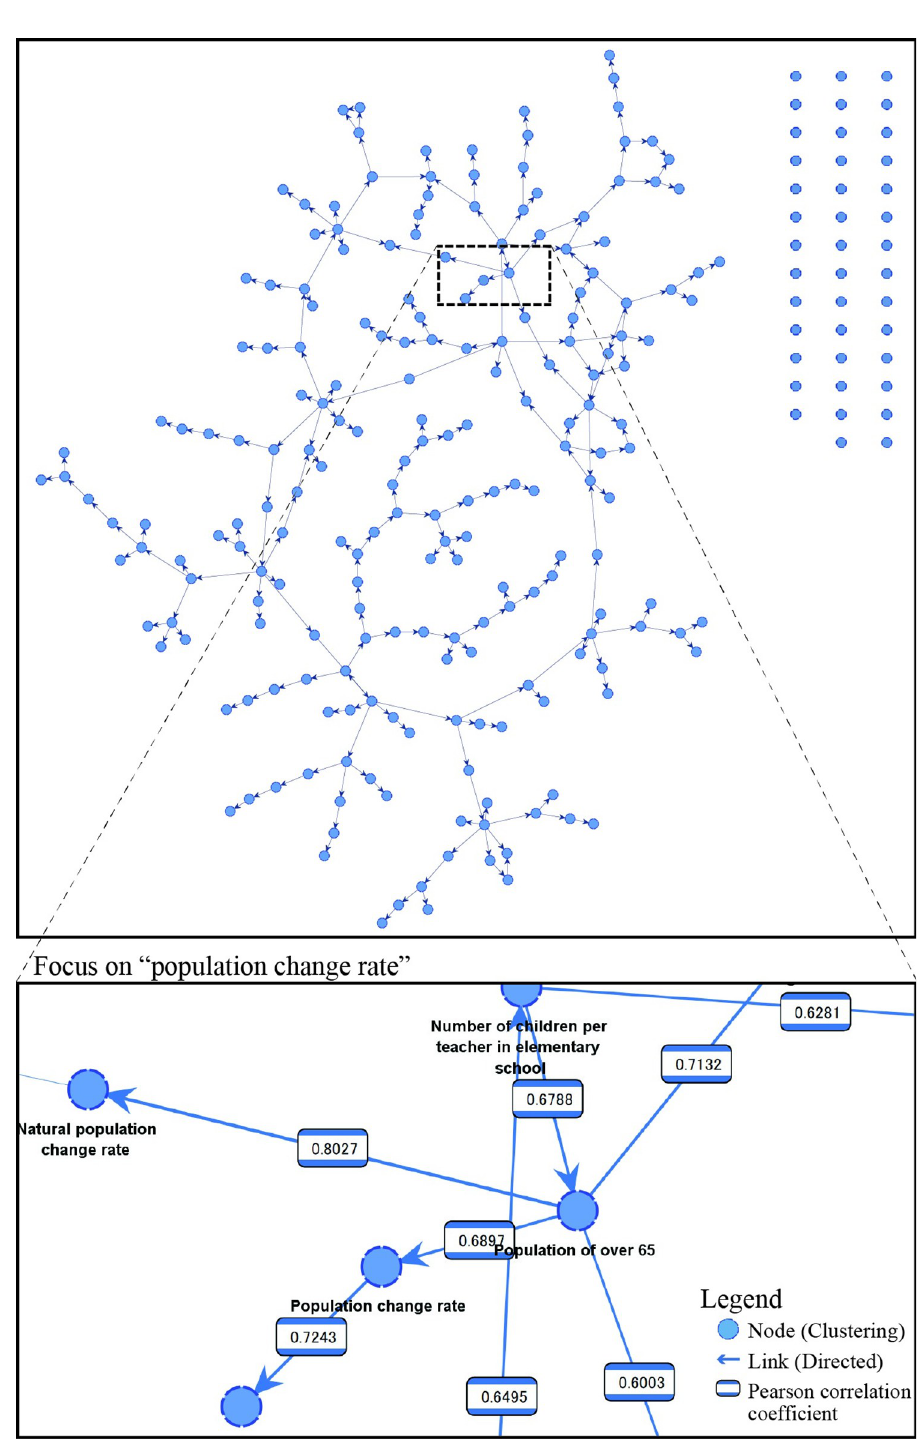
Fig 2. Bayesian network of shrinking cities. The upper graph shows the whole network. The lower graph shows the network around the PCR. In the lower graph, numbers between links indicate the Pearson’s correlation coefficient.